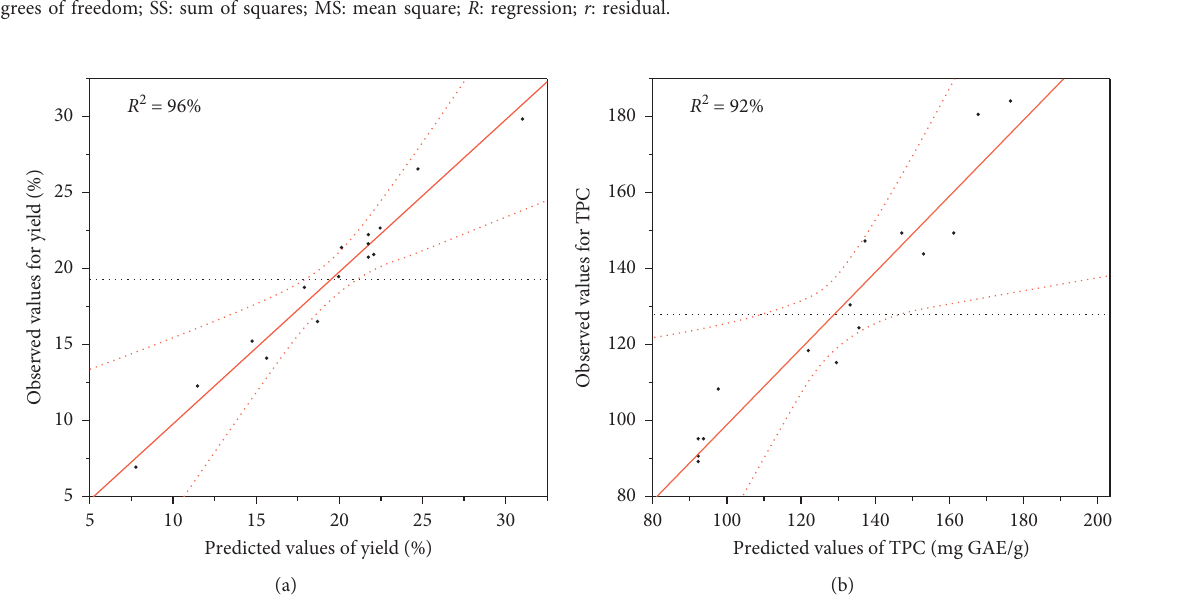
Figure 1: Curves of the observed values in terms of the predicted values for the two studied responses (a) yield and (b) TPC.